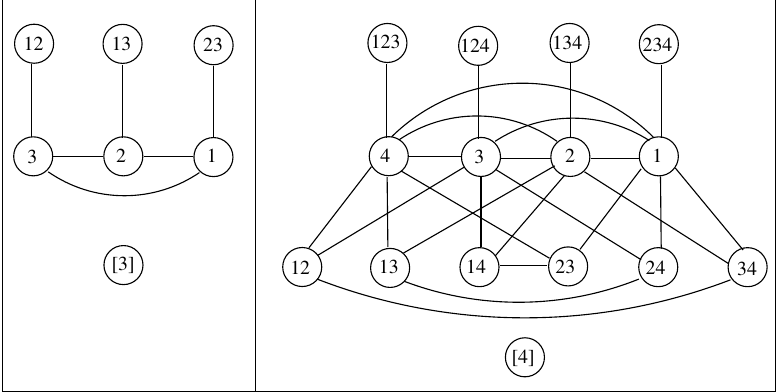
Figure 1: The graphs F